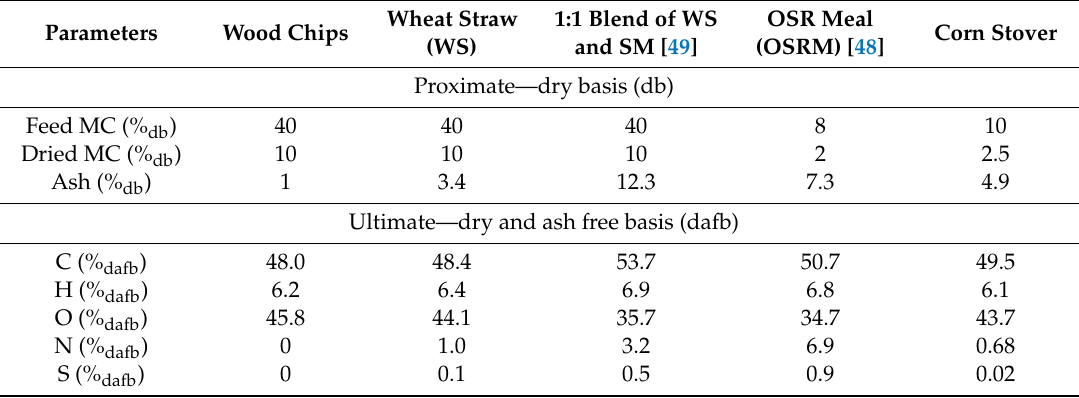
Table 3. Actual Proximate and Ultimate values used in gasification